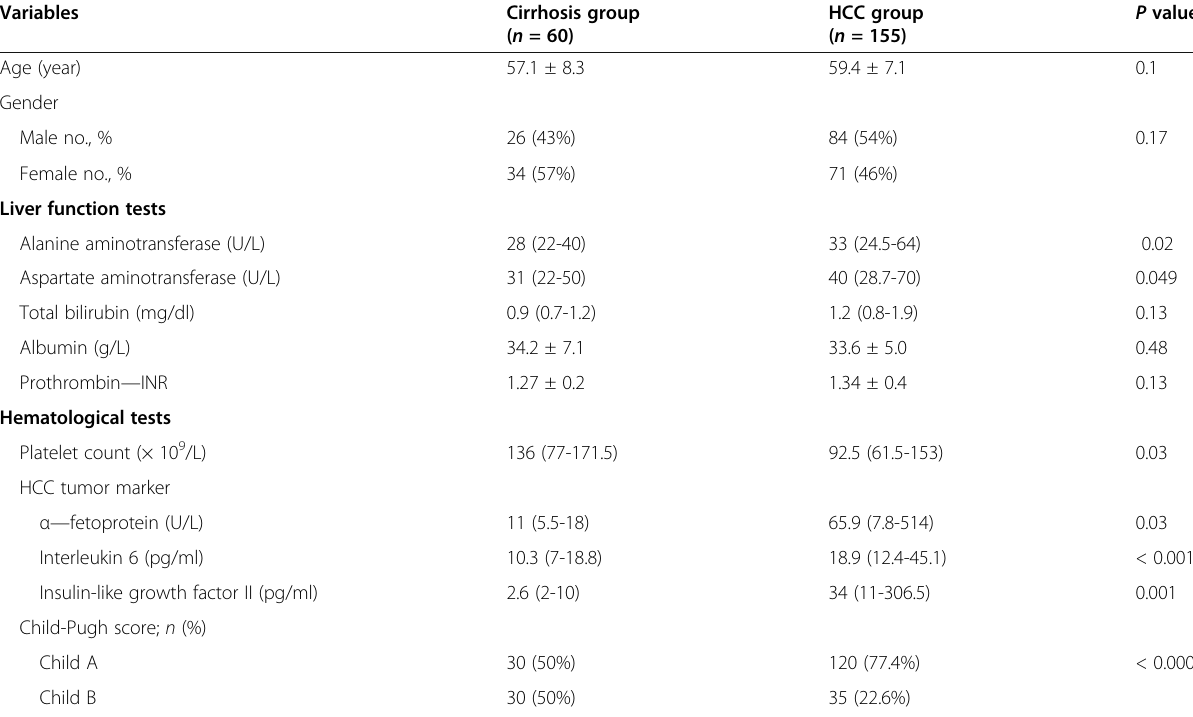
Table 1 Clinical and laboratory data of the studied groups Variables